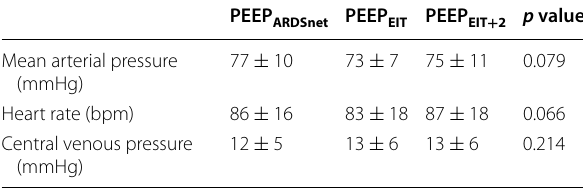
Table 3 Hemodynamics during all study phases